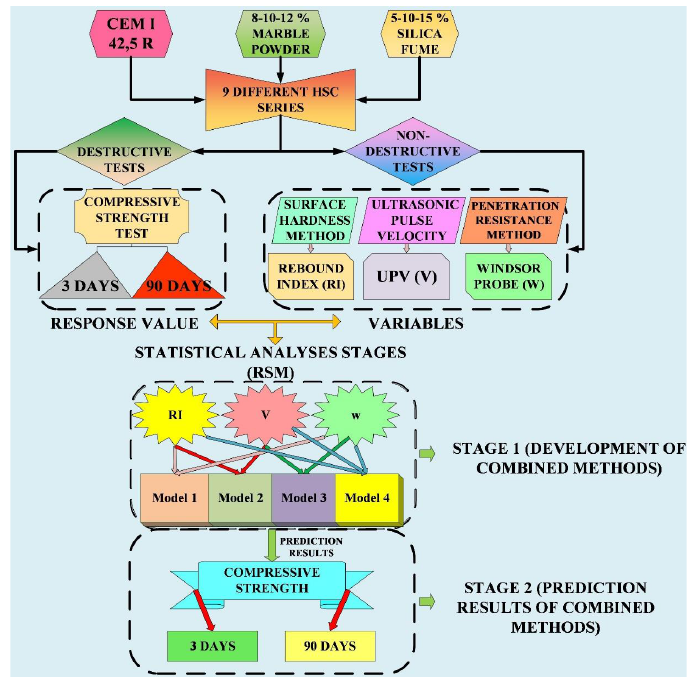
Figure 1. Flow chart of the presented study.